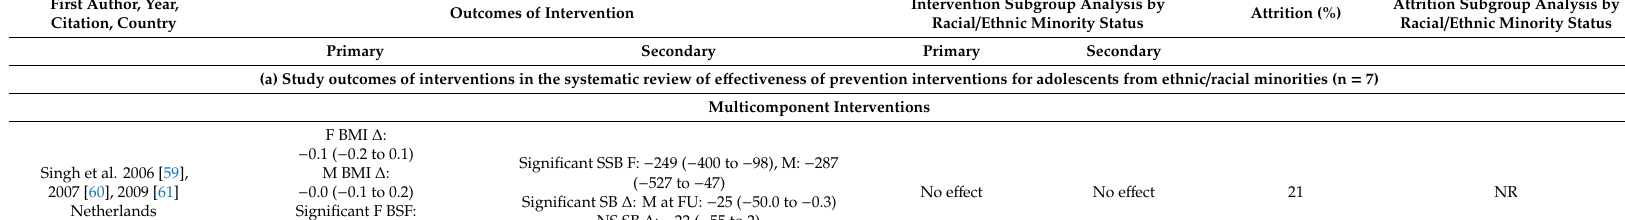
Table 2. Study outcomes of interventions in the systematic review of e ff ectiveness of prevention interventions for adolescents from ethnic / racial minorities. First Author, Year, Citation, Country (a) Study outcomes of interventions in the systematic review of e ff ectiveness of prevention interventions for adolescents from ethnic / racial minorities (n = 7) Multicomponent